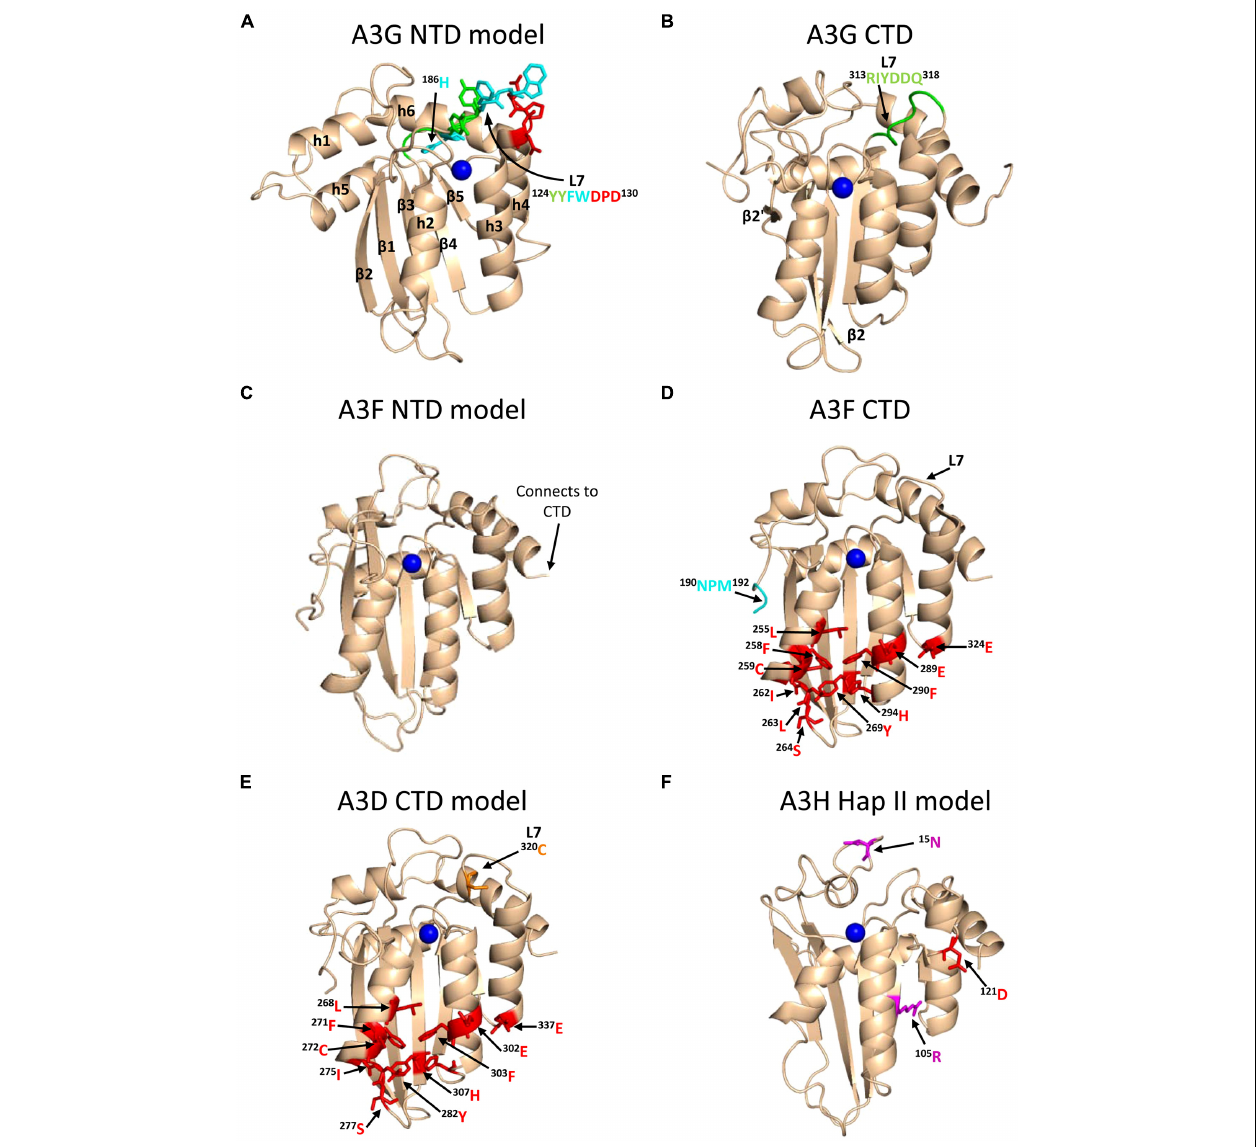
FIGURE 3 | Structures of A3 enzymes. A3 enzymes have a basic structure in each Z-type domain that is composed of a five-stranded β -sheet core surrounded by six α -helices. Numerical assignments to β -strands and α -helices are superimposed in (A) . Zinc atoms are shown as blue spheres. (A) Model of the N-terminal domain (NTD) of A3G. Loop 7 (L7) of the A3G NTD is a central structure in its anti-HIV function. Highlighted on L7 are the residues important for interaction with Vif (red, 128 DPD 130 ), oligomerization/virion encapsidation (green and cyan, 124 YYFW 127 ), and jumping component of A3G processivity (cyan, 126 FW 127 ). Helix 6 (h6) is adjacent to L7 and contributes to the sliding component of A3G processivity, particularly 186 H (cyan). The model of the A3G NTD was obtained by using the automated SWISS-MODEL program using the homologous A3G C-terminal domain structure (CTD, PDB: 3IQS). (B) The A3G CTD (PDB: 2KEM) is the catalytic domain of A3G. The A3G CTD has a discontinuous β 2 strand forming a loop-like bulge between the β 2 and β 2 (cid:2) strands. A3G L7 residues 313 RIYDDQ 318 (green) mediate tetramerization and determine the preferred deamination motif. (C) The model of the A3F NTD was obtained by using the automated SWISS-MODEL program using the homologous A3C structure (PDB: 3VM8). The end of h6 connects the NTD to the CTD and